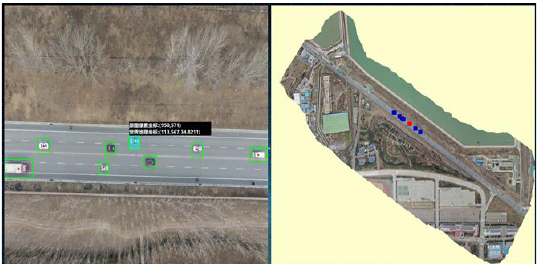
Figure 7. Moving vehicle targets detection and geolocation for different flight altitude. ( In the left figure, the green box is used to express different classes of vehicle targets detected by the YOLOv3 network model. The pixel coordinates of the vehicle detected center point are indicated by red crosses, and the blue box shows the geo-location of the target ， the red box shows the selected target in the right figure on the reference map.